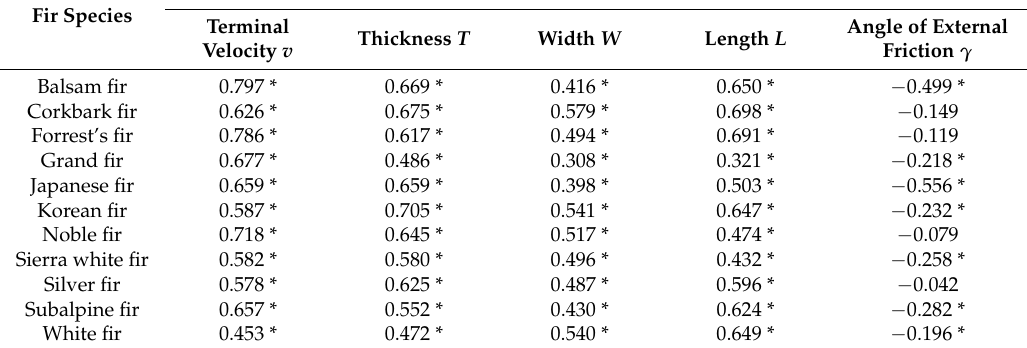
Table 4. Coefficients of linear correlation between seed mass and the remaining physical properties of fir seeds. Coefficient of Correlation between Seed Mass m Fir Species